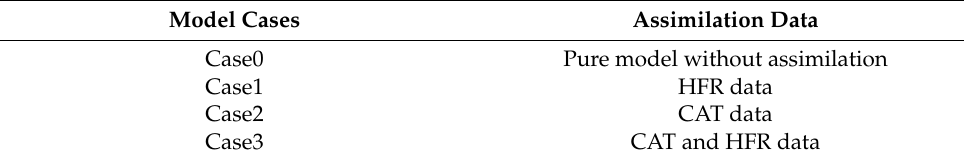
Table 2. Descriptions of assimilation